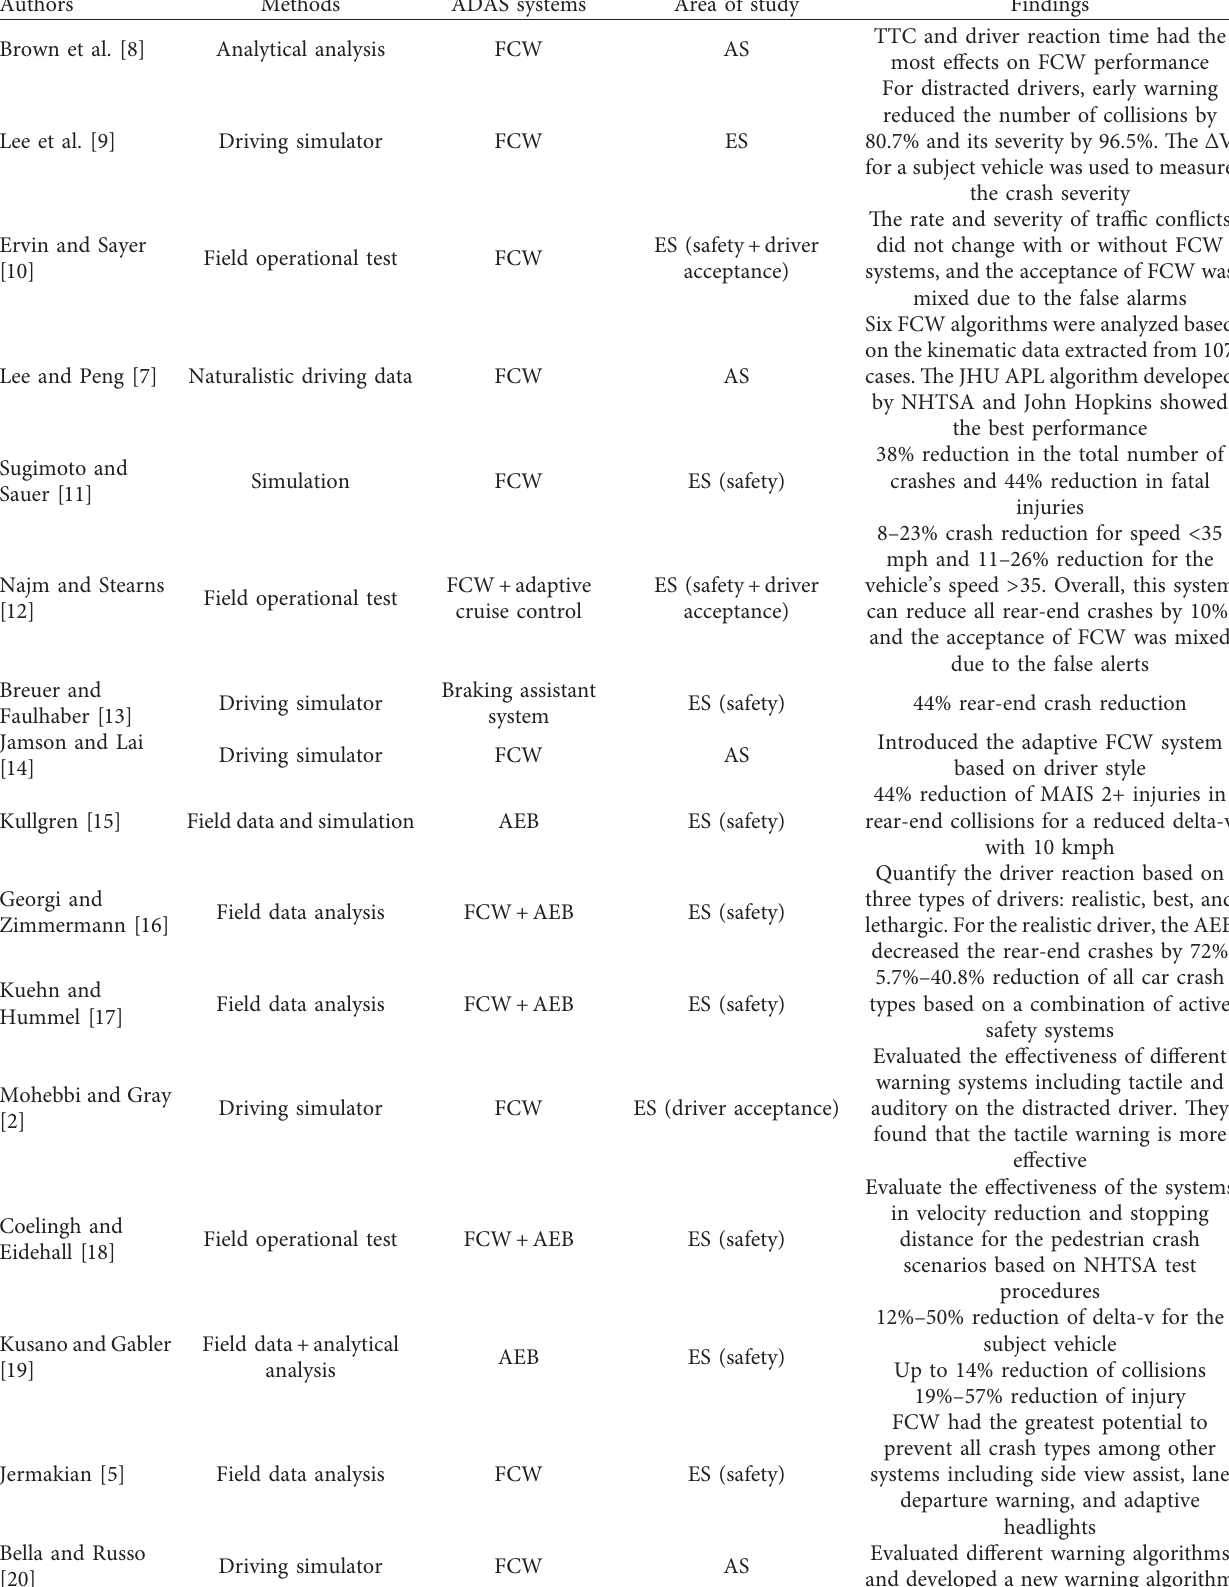
Table 1: Summary of research on FCW and